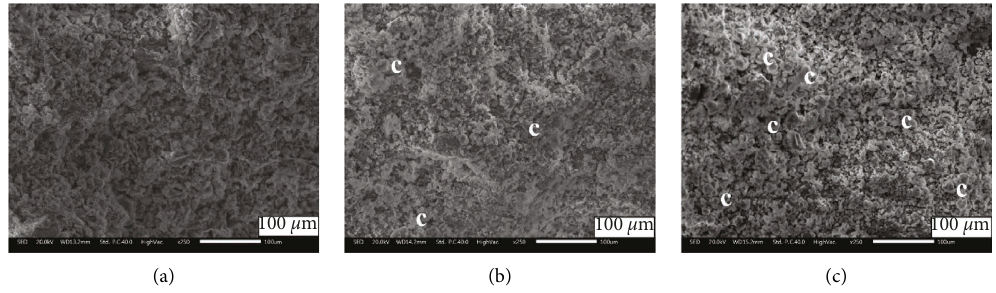
Figure 3: SEM image of cement formed in deionized water (a), bacterial suspension (b), and bacterial suspension with reaction solution